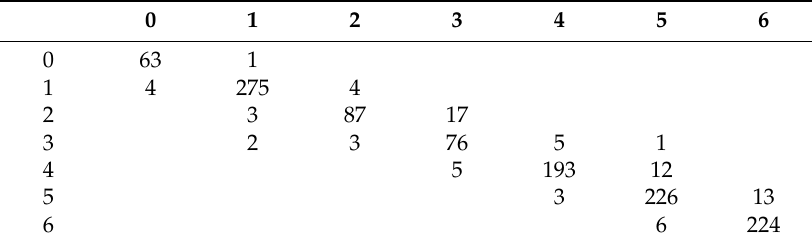
Table A1. The confusion matrix of Figure 7b.